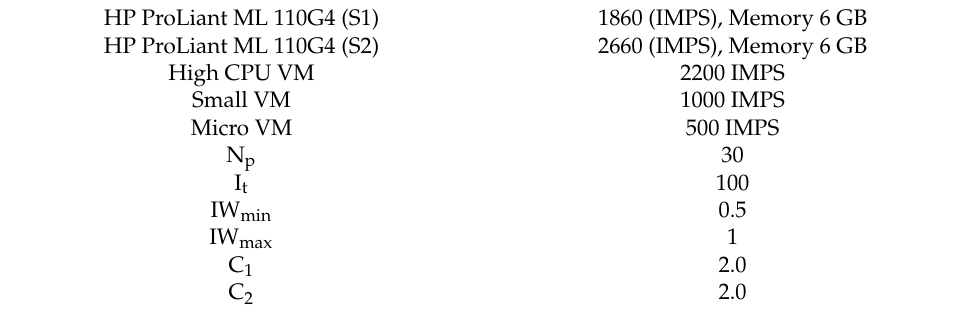
Table 2. Proposed CEWOAVM parameters.